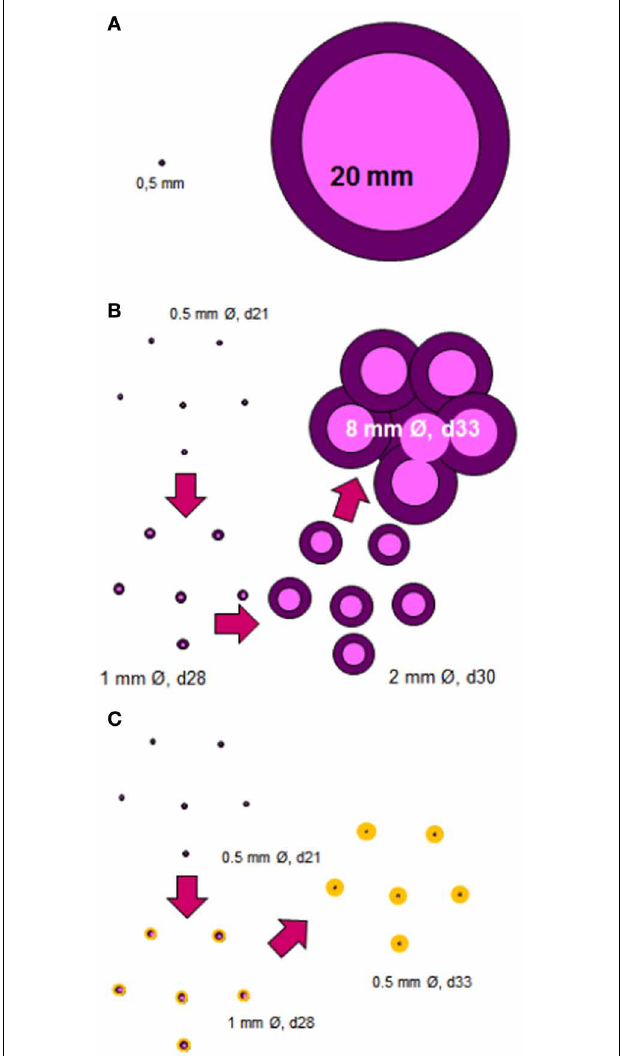
FIGURE 1 | Induction of cavitated lesions. The most important question is how a granuloma with a diameter of about 0.5mm can increase in size to around 25mm, which is the size required to start a cavity (A) . The answer lies in the murine C3HeB/FeJ infection model. In this model, the size of the lesions increases quickly over around 12 days thanks to the massive accumulation of neutrophils, which allows extracellular growth of the bacilli (Marzo et al., 2013), and to the coalescence of some of these lesions (B) . The anti-inflammatory preventive intervention should avoid the excessive growth of individual granulomas thus allowing the encapsulation process to occur, and thus avoiding the coalescence and the cavity formation (C) .